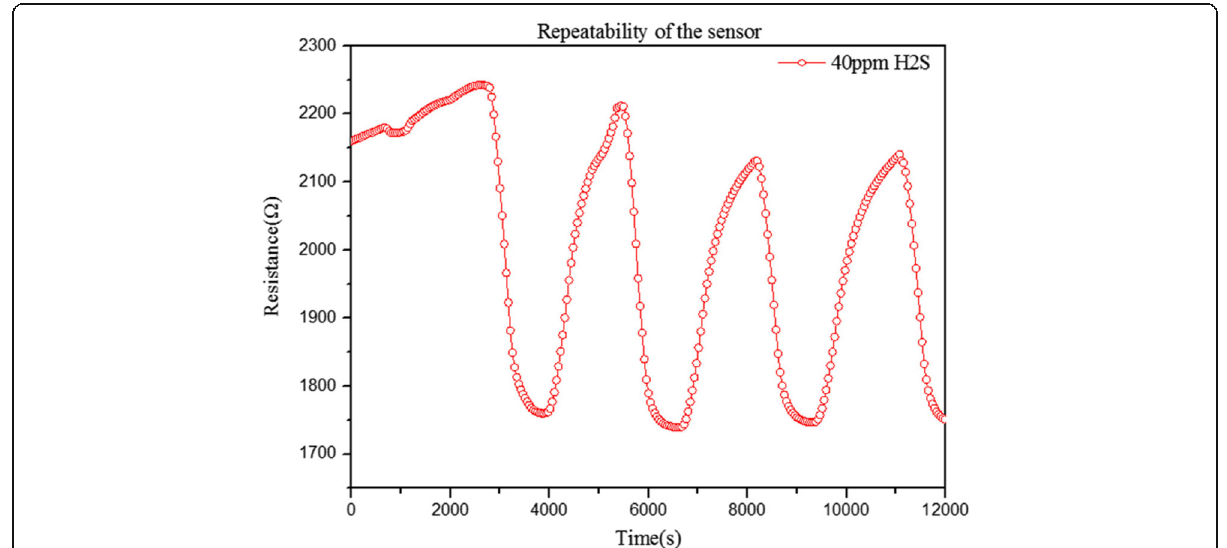
Fig. 7 Repeatability of the sensor of CNTs/SnO 2 /CuO in the concentration of 40 ppm H 2 S